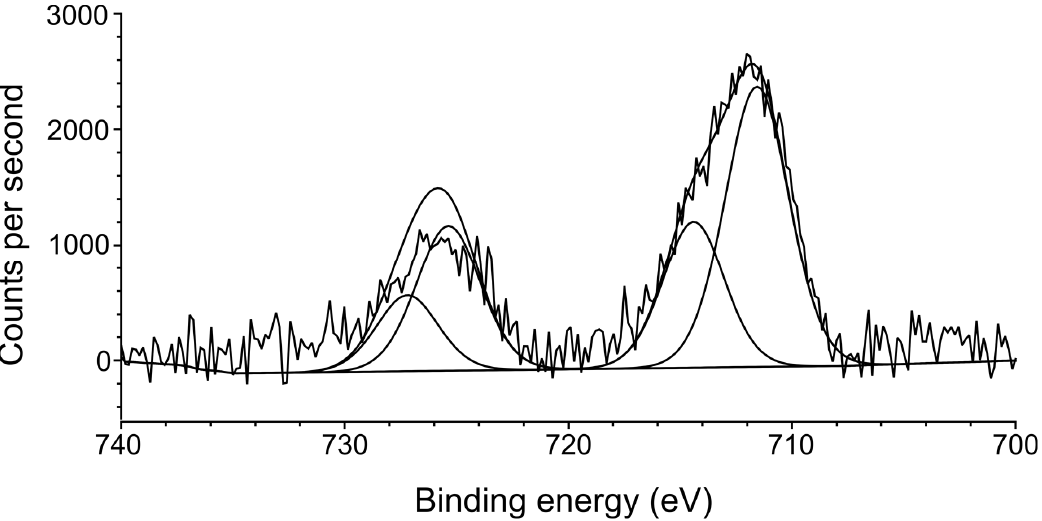
Figure 5. X-ray photoelectron spectroscopy of Na-NZU. Doublet separation was 13.50 eV.